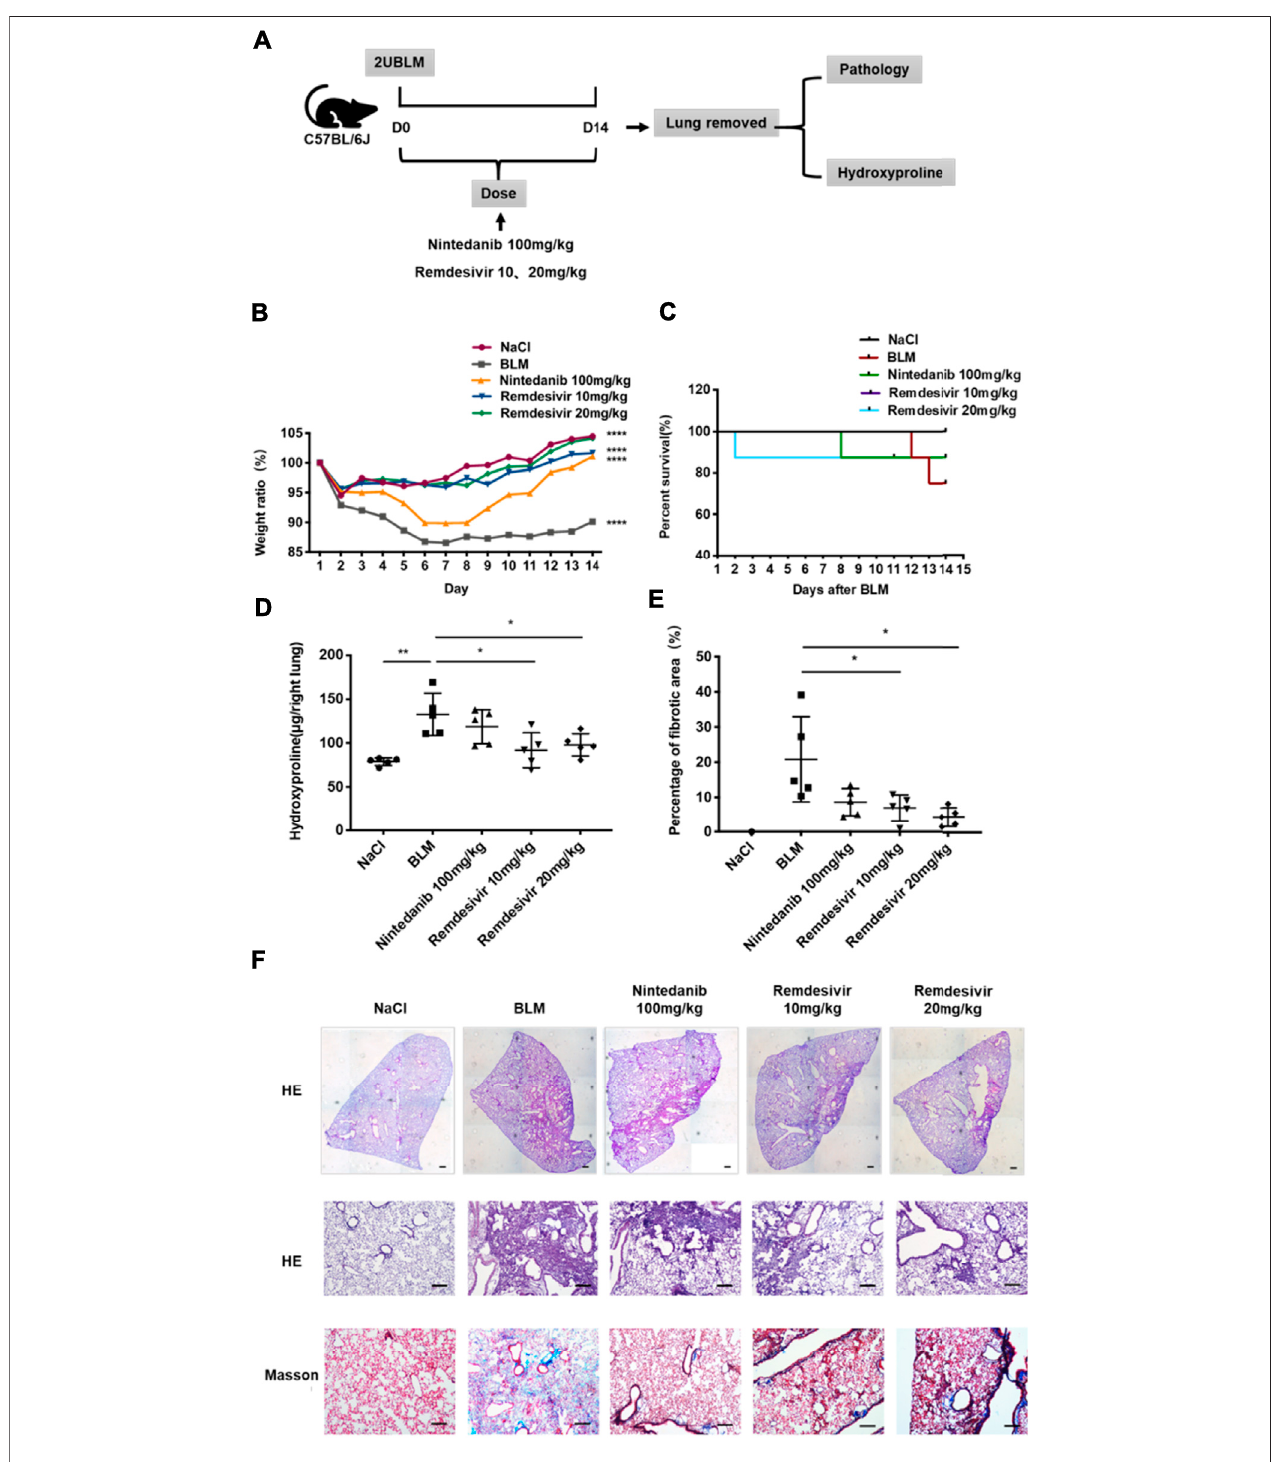
FIGURE 1 | Remdesivir ameliorates BLM-induced pulmonary fi brosis in mice. (A) Dosing regimen in BLM-induced pulmonary fi brosis model. (B) Changes in body weight relative to initial body weight during administration. (C) Percentages of surviving mice were plotted from day 1 – 14 after BLM treatment. (D) Hydroxyproline contents of lung tissues in mice. (E) Statistics of lung fi brosis area among groups. (F) Lung tissue sections were stained with hematoxylin-eosin (H and E) and Masson Trichrome staining. Scale bar (cid:1) 50 μ m. Data was noted as the means ± SD, n (cid:1) 5. * p < 0.05, ** p < 0.01, **** p < 0.0001.